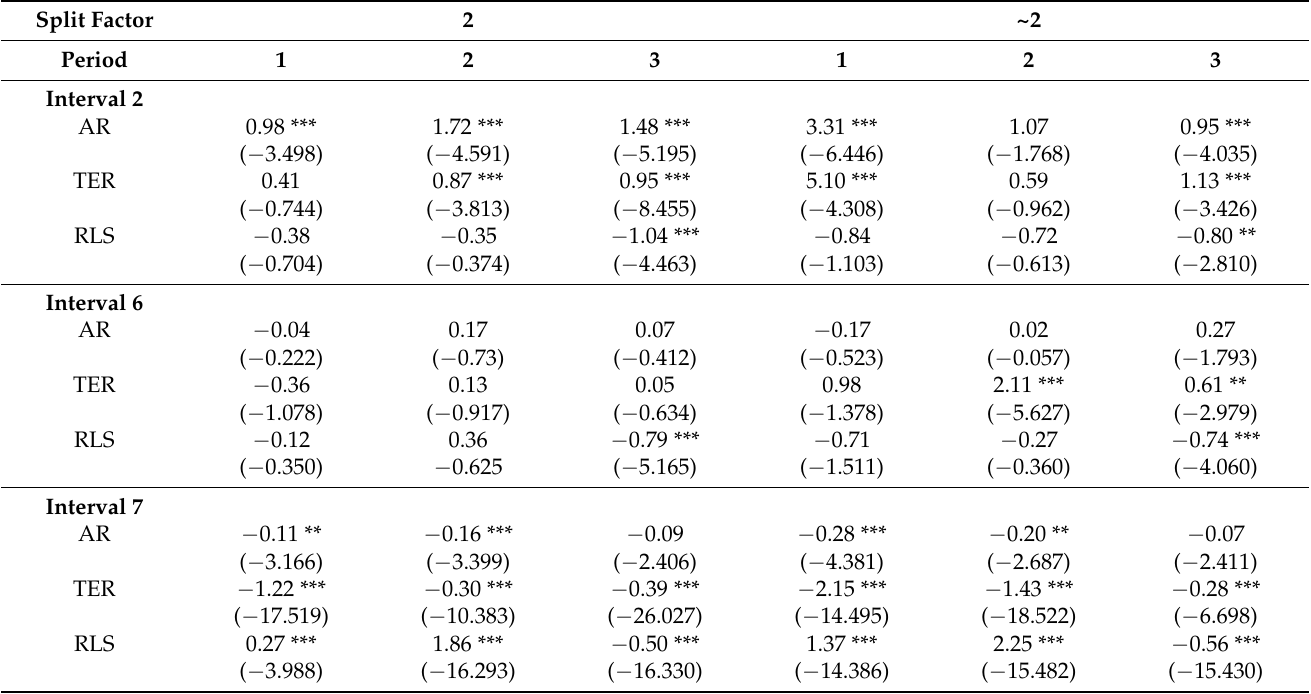
Table 4. Abnormal returns (%) and liquidity measures (%) by study period control variable: split factor. Split Factor 2 ~2